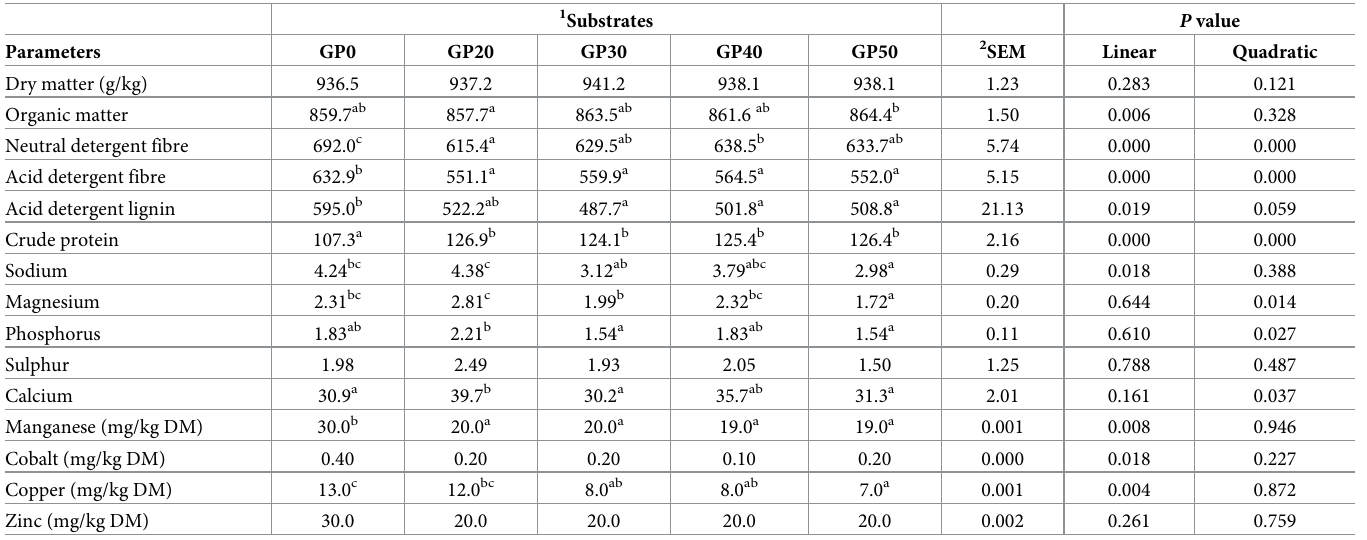
Table 1. Red grape pomace spent mushroom substrate chemical composition (g/kg DM, unless stated otherwise) in response to graded levels of oyster mushroom spawn.